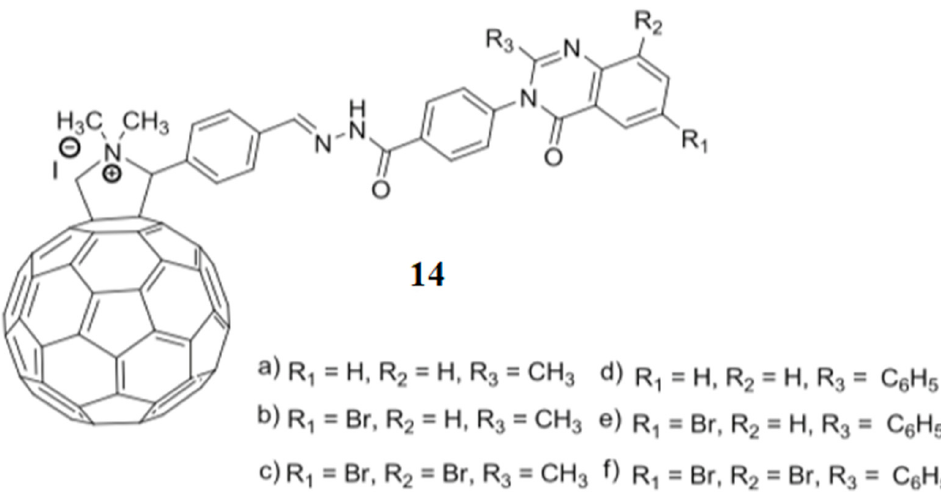
Figure 2 . Compound 14 docked into the binding site of M. tuberculosis hypoxanthine-guanine phos- phoribosyl transferase enzyme [15]. Another 2018 study proved that the effect of the derivatives, such as 2-mercapto- 4(3 H)- quinazolinone scaffold ( 15 and 16 ), as a potent inhibitor against mycobacterial non- proton pumping type II NADH dehydrogenase (NDH-2) in turn plays a critical role in the respiratory metabolism of bacteria. Therefore, SAR studies were performed to understand the activity of potent compounds and have concluded the importance of the quinazoli- none core for the activity as well as the S-linker [17]. A more recent 2019 study investigated the anti-tuberculosis activity of 4(3 H )-quinazolinones linked to 1,2,3-triazole hybrids ( 17 ). It included the design, synthesis, and docking studies for the proposed agents. It was con- cluded that the addition of the triazole fragment enhanced the activity of quinazolinone derivatives, whereas the addition of aromatic groups increased the binding interactions